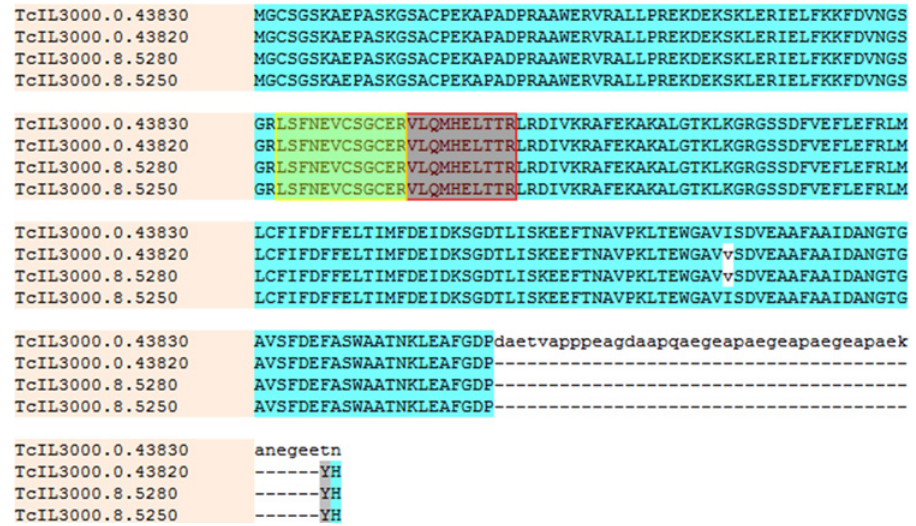
Fig 3. Multiple sequence alignment of the T . congolense calflagins. The positions of the two MS- identified tryptic peptides identified by mass spectrometry are highlighted in yellow and red boxes. The lower case, white highlighted v represent amino acid (valine-isoleucine) differences in two of the